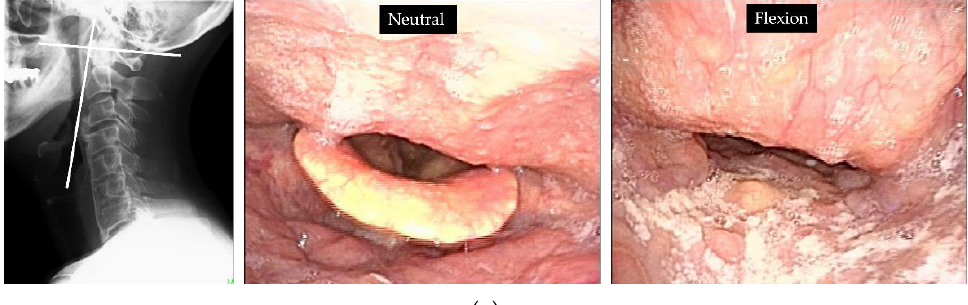
Figure 4. Case 2. C3/4 OALL increased from 6.8 mm ( a ) to 11.6 mm ( b ) since the first X-ray and CT 6 years ago. ( c ) No evidence of spinal cord compression on MRI. ( d ) VF showed narrowing of the pharyngeal cavity in the area of ossification, which was further exacerbated by flexion (arrow). ( e ) The S-line was negative. VE: the pharyngeal cavity was compressed and narrowed anteriorly due to ossification, which was further exacerbated by flexion.